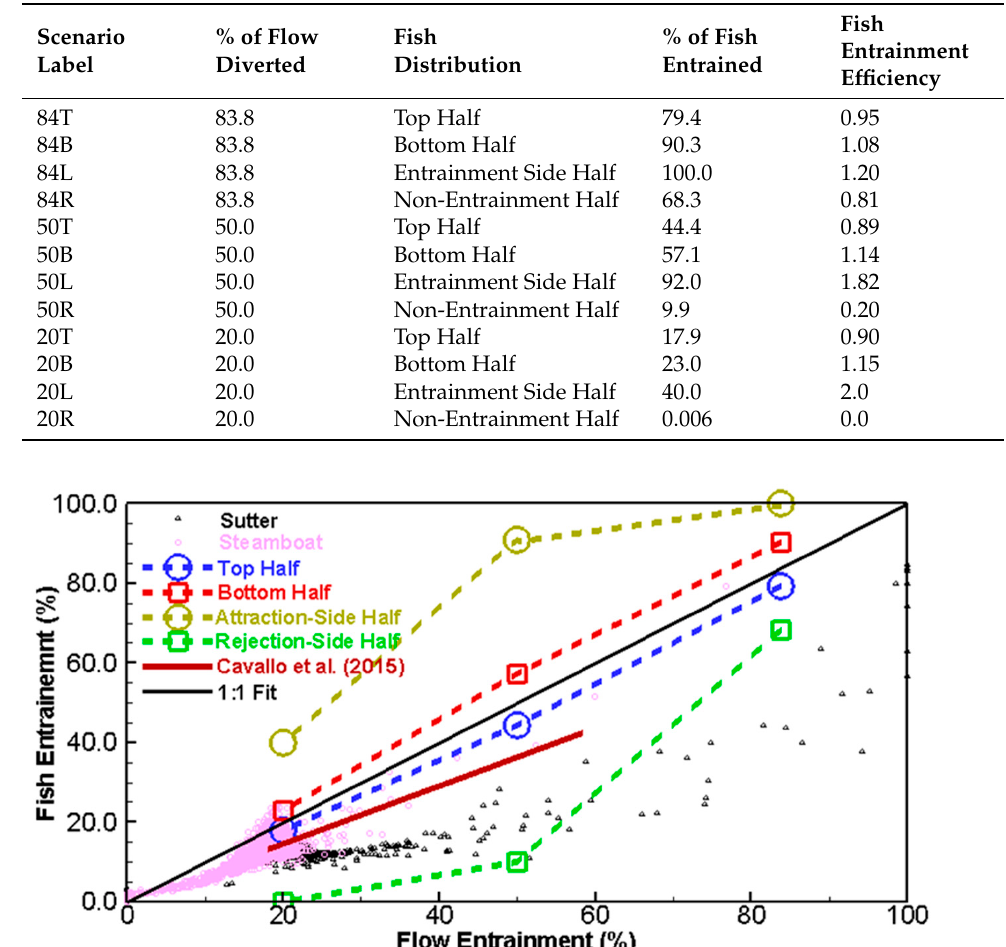
Table 1. Fish entrainment efficiency for the case of Ramamurthy et al. [3].